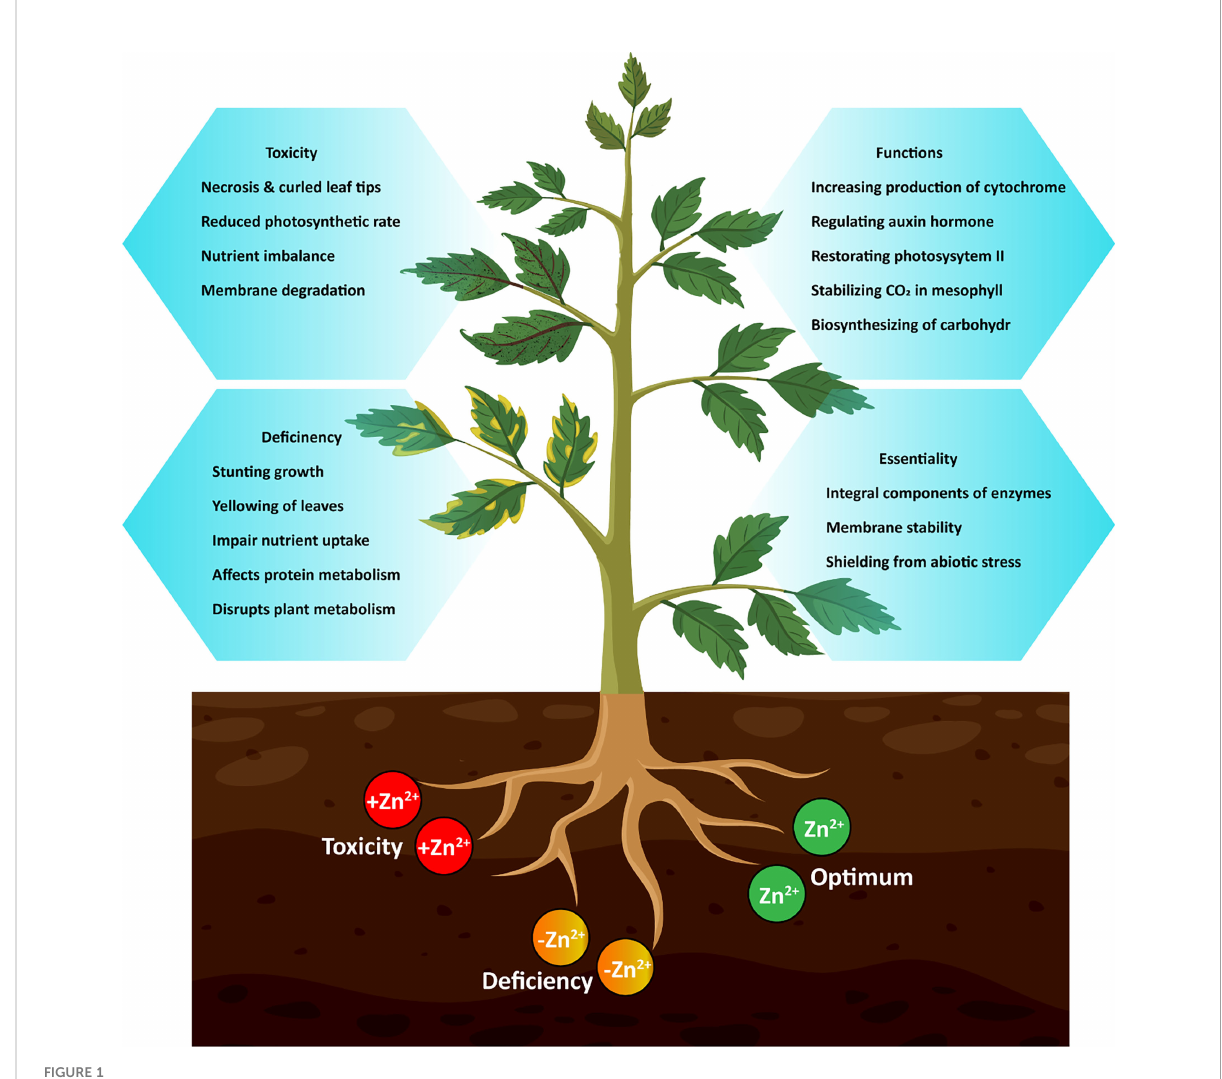
FIGURE 1 Functions, de fi ciency and toxicity effect of Zn on